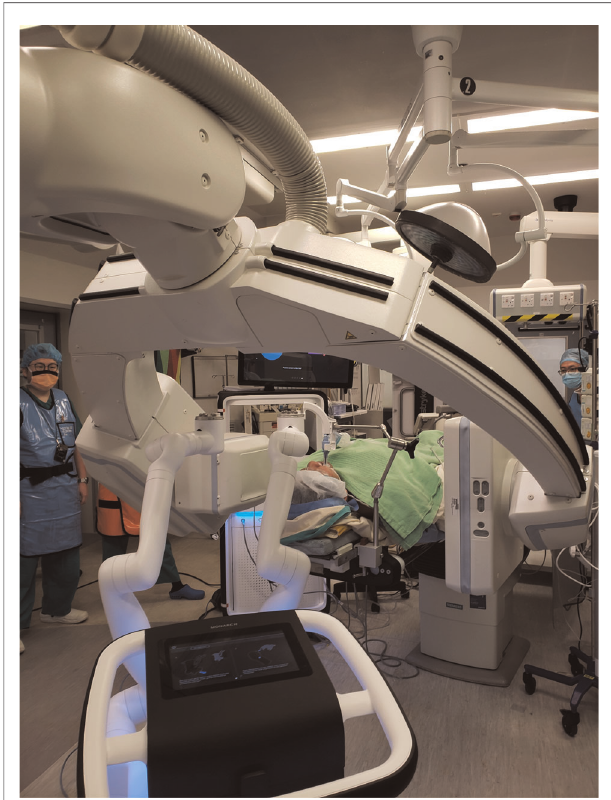
FIGURE 5 | The left robotic arm can be seen in very close proximity to the cone-beam CT (CBCT) C-arm during CBCT spin. The metallic holder of the endotracheal tube is also close to the other side of the CBCT C-arm. Care must be taken to avoid collisions in these two